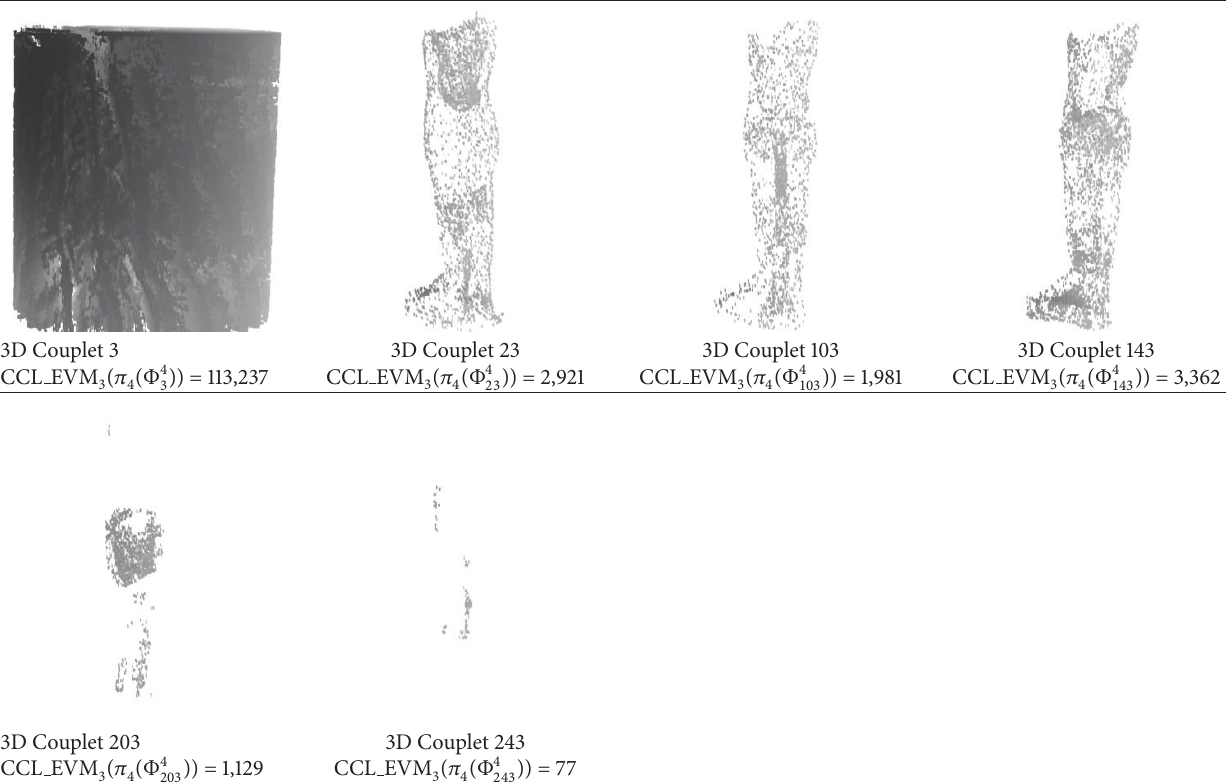
Table 5: Some 3D Couplets, perpendicular to color axis, extracted from the 4D-EVM associated to dataset Statue Leg